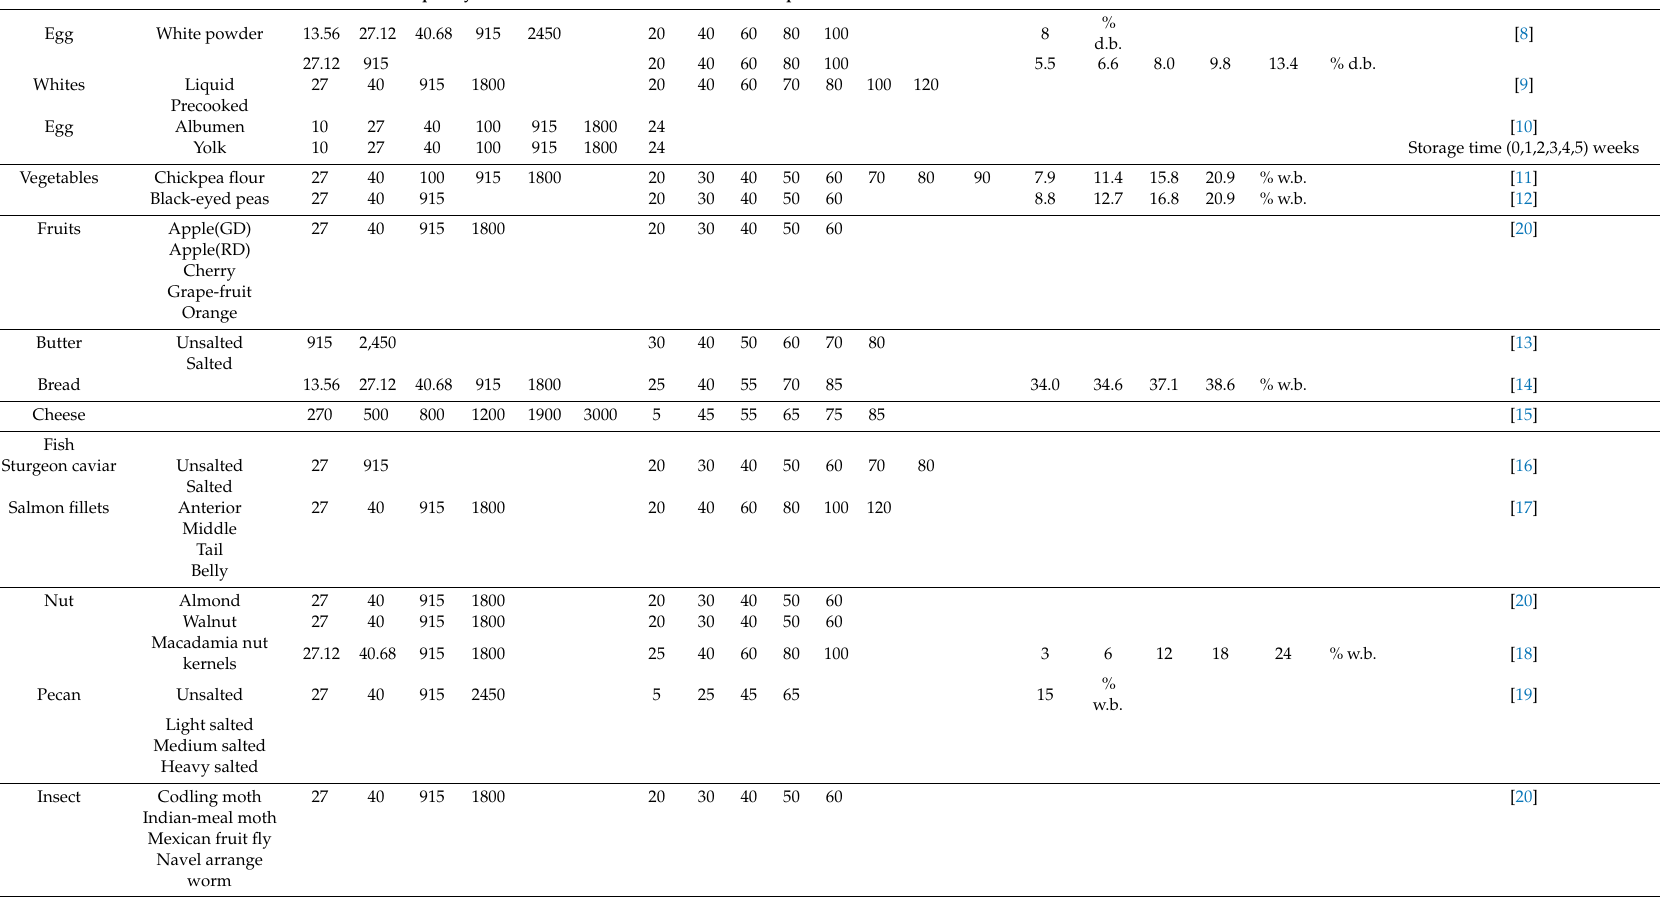
Table 2. Published data for dielectric properties in the